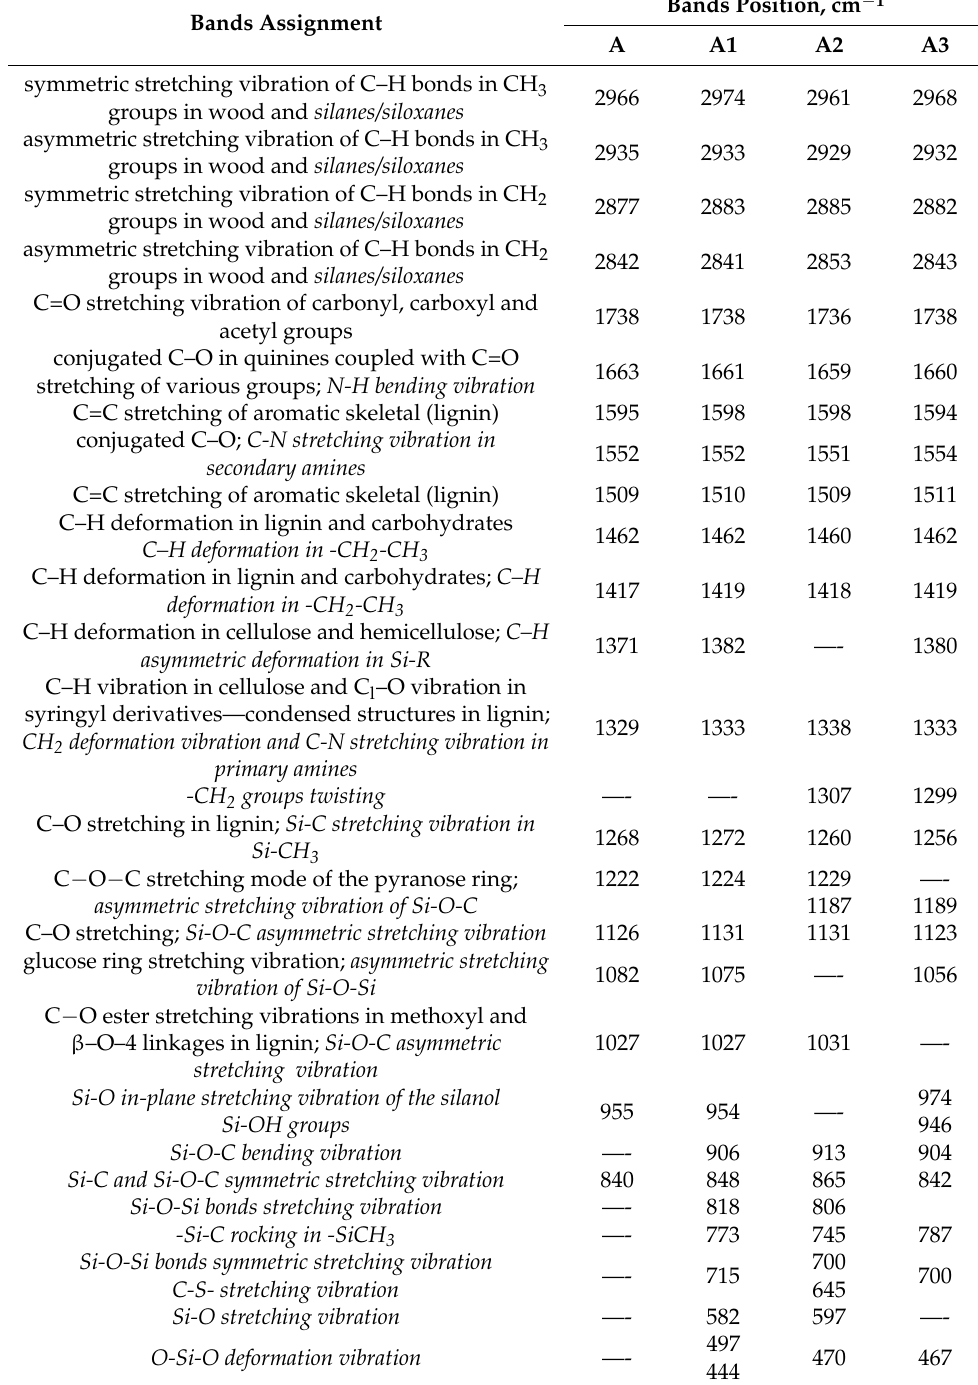
Bands Position, cm −